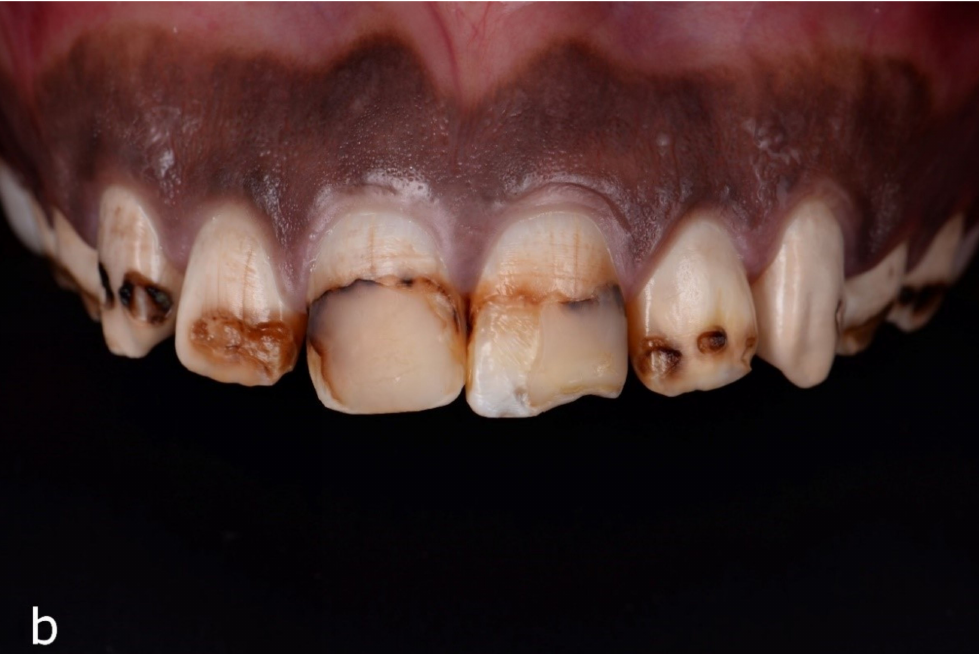
Figure 1. Extraoral view of pretreatment; ( a ) full smile and ( b ) retracted view of maxillary anterior